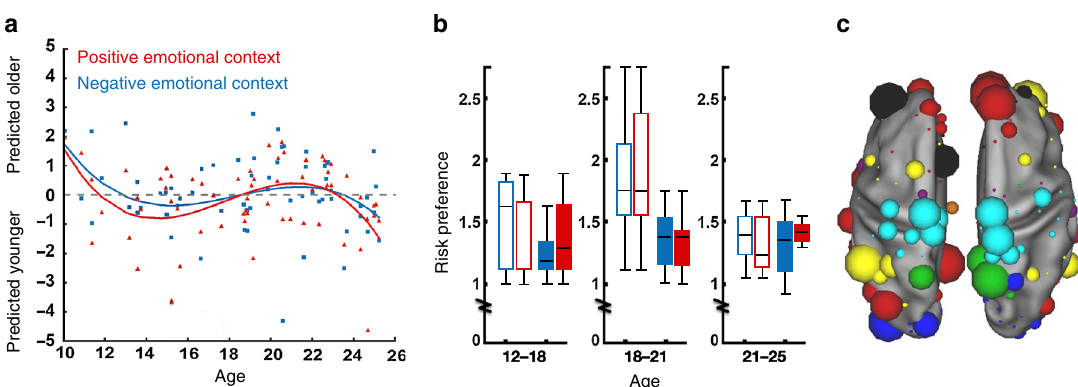
Fig. 3 Adolescents ’ functional connectivity patterns look younger in emotional contexts. Adapted with permission from Rudolph et al. 97 . a Chronological age is plotted against age predicted from functional connectivity patterns observed in positive and negative emotional contexts. Individual points (participants) are fi t with polynomial curves. On average, adolescents are predicted younger in emotional contexts. b Adolescents (age 12 – 18; numerical difference) and young adults (age 18 – 21; p < 0.1 in negative emotional contexts and p < 0.05 in positive emotional contexts) who are predicted younger in emotional contexts tend to show greater risk preference. This trend is most pronounced in young adulthood. Open bars represent individuals predicted younger in emotional contexts, and fi lled bars represent individuals predicted older. Red bars show participants grouped by age predictions in positive emotional contexts; blue bars show participants grouped by age predictions in negative emotional contexts. c Functional network nodes, scaled by their importance in the age-prediction model, are grouped into the following functional networks de fi ned previously 13 : default mode (red), dorsal attention (green), frontoparietal (yellow), salience (black), cingulo-opercular (purple), visual (blue), subcortical (orange), and ventral attention